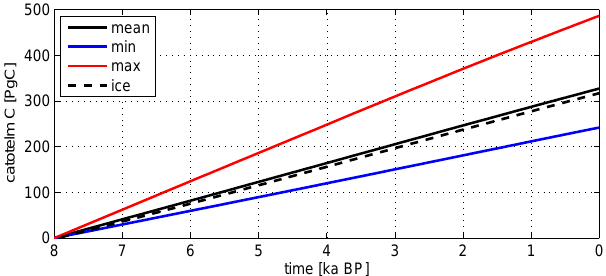
Fig. 8. Total carbon accumulation as catotelm peat in wetlands for